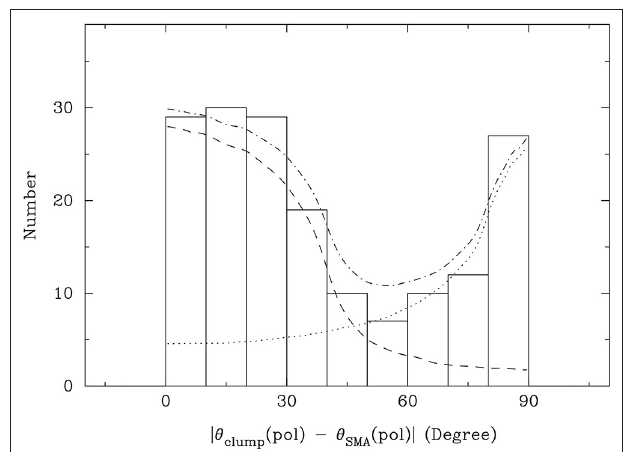
FIGURE 8 | The distribution of polarization angles in dense cores with respect to polarization angles of their parental clumps. The dashed line represents the probability distribution of the plane-of-the-sky-projected orientations of pairs of vectors with 0 40 ◦ opening angles randomly oriented in space. The dotted − line represents the probability distribution where the vectors are preferentially perpendicular, with 80 90 ◦ opening angles. The dashed-dotted line − represents the contributions from the two distributions. Adapted from Zhang et al. (2014) . Figures reproduced with permission from the